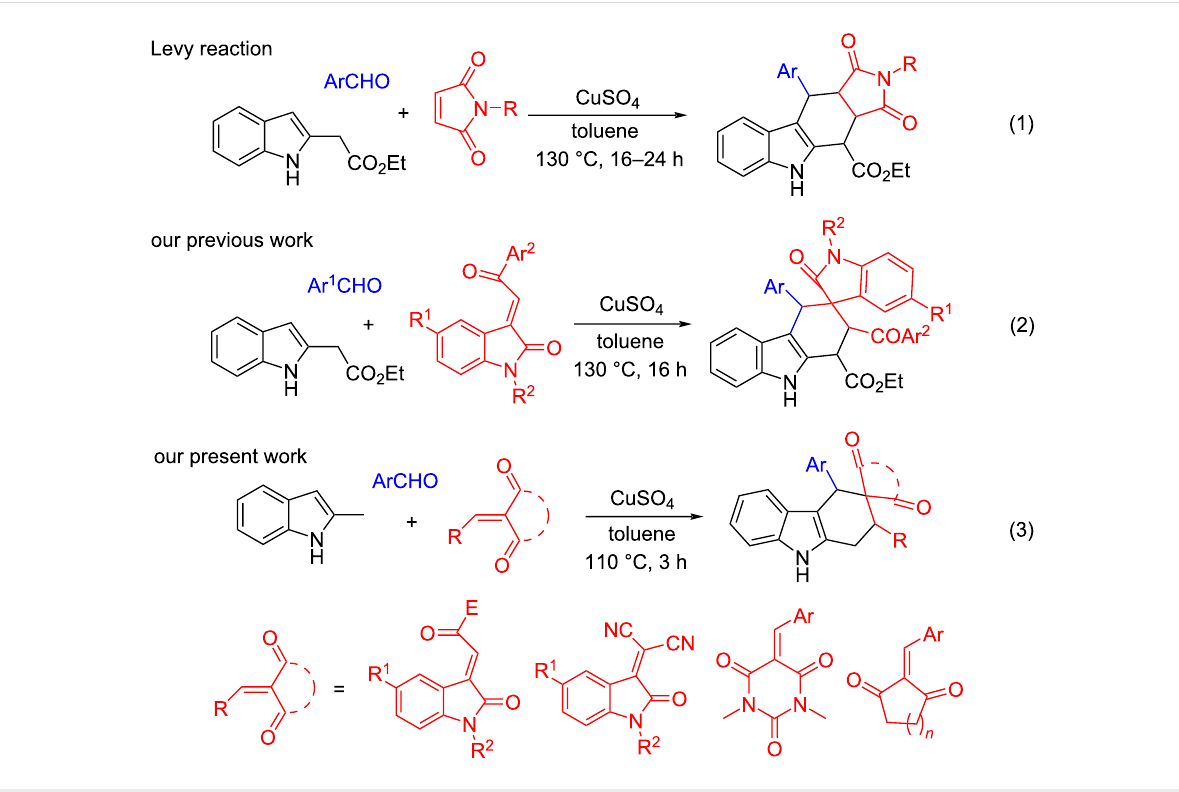
Scheme 1: Construction of diverse tetrahydrocarbazoles via Levy-type